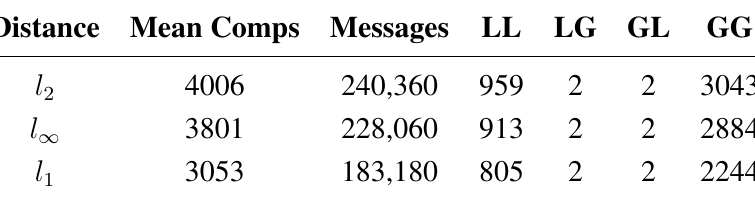
Table 2. number of mean computations, messages, and crossings per norm for feature “bosnia” with threshold r = 0 . 0025